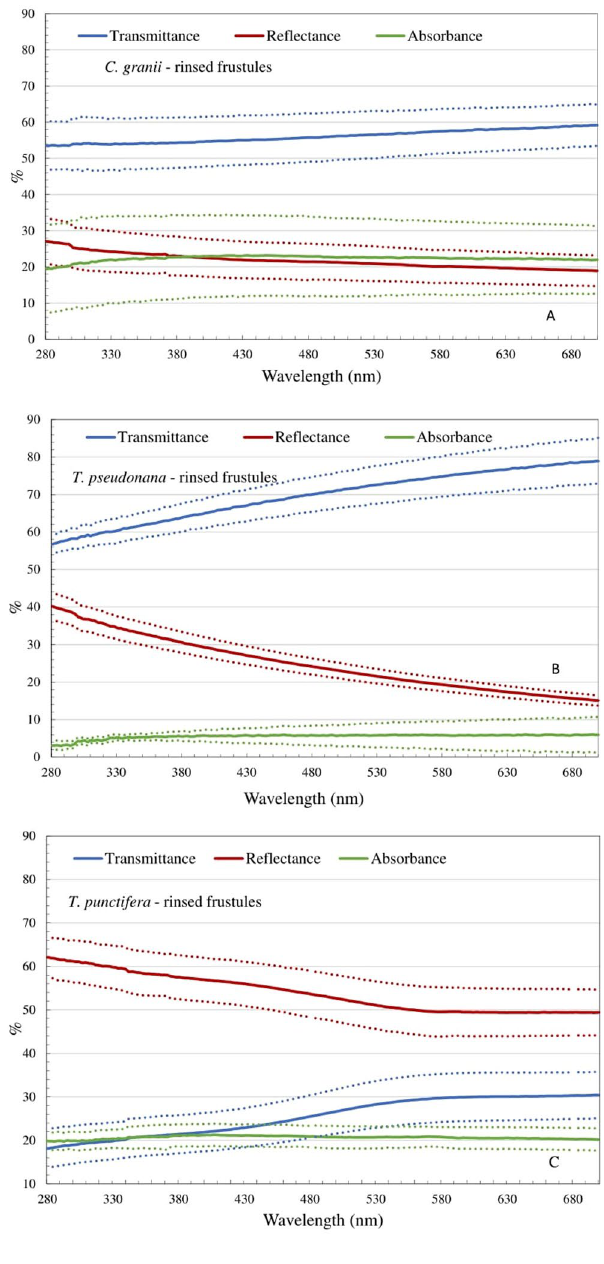
Figure 1. Spectral transmittance (blue), reflectance (red) and absorbance (green) for a coating of rinsed C. granii ( A ), T. pseudonana ( B ) and T. punctifera ( C ) frustules. The dotted lines represent the mean value ± the standard deviation. The reference spectrum is the UV-transparent quartz silica microscope glass plate with milli q water on top of it. All the values are normalized to 100%